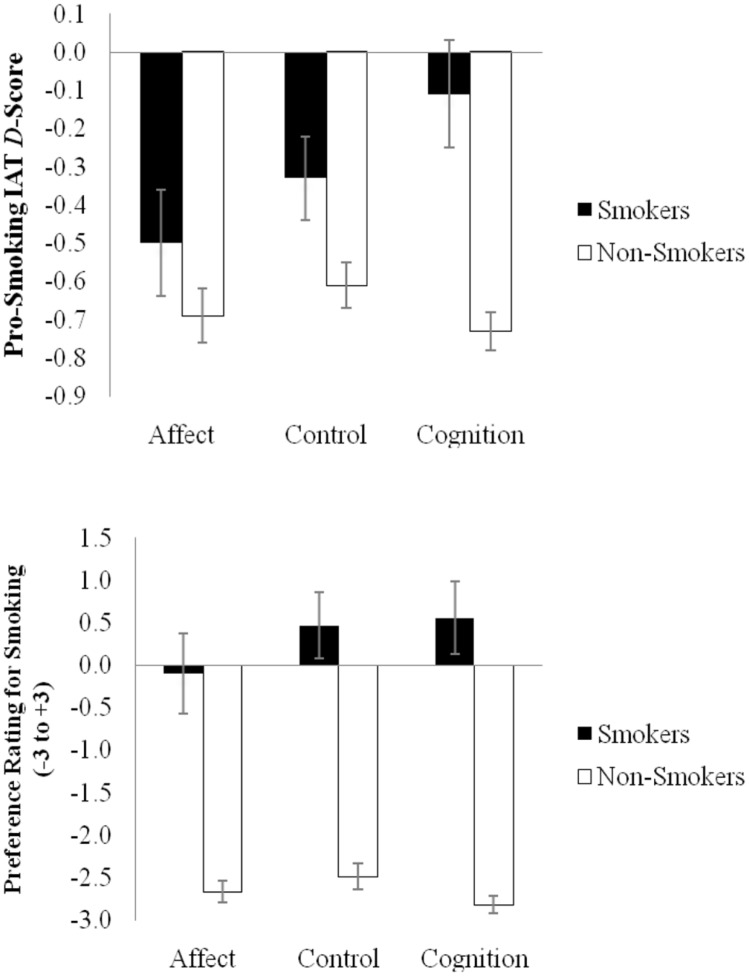
IAT D-scores (top) and preference ratings (bottom) for smoking as a function of smoking status and the type of persuasive message in Study 3. Positive scores indicate a preference for smoking. Error bars indicate the 95% confidence interval around the mean.